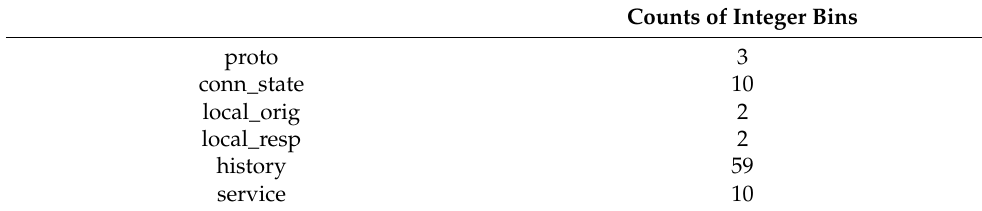
Table 6. Number of bins for integer attributes in Zeek Conn